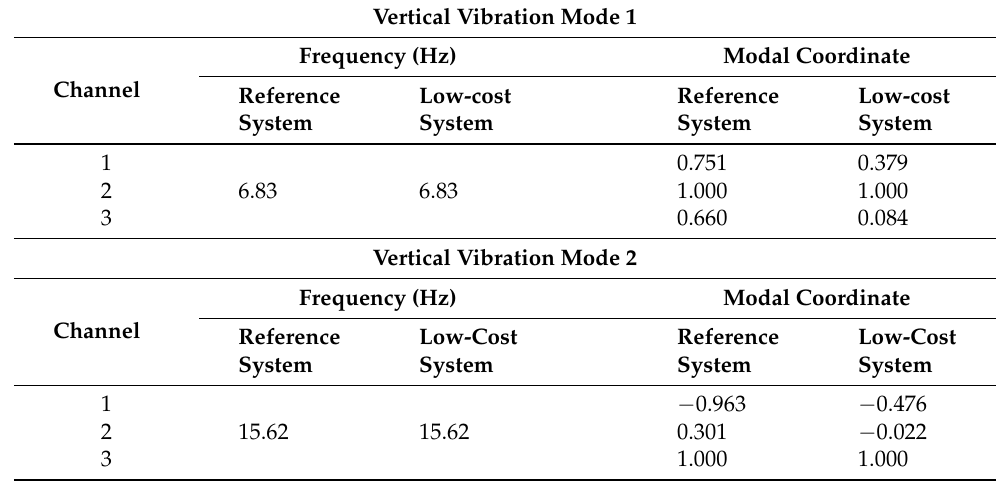
Table 9. Vertical natural frequencies and mode shapes identified of the steel structure by both monitoring